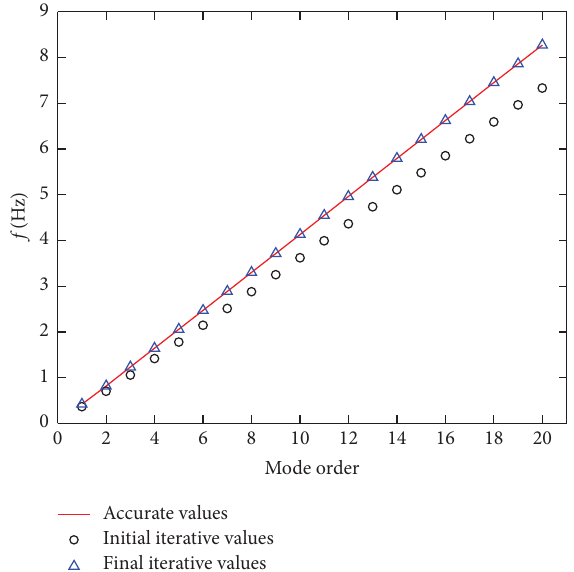
Figure 10: Convergence of (a) correction coefcients F identifcation process.